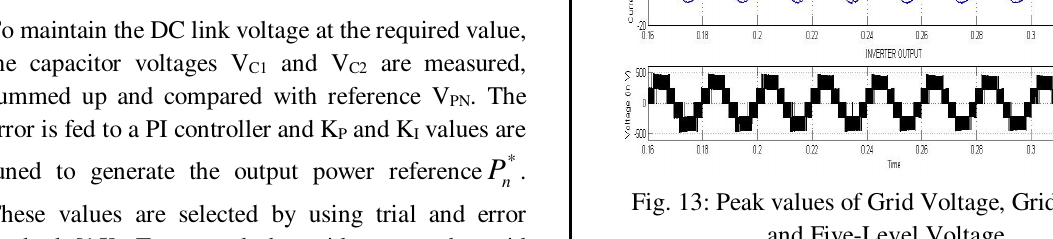
Fig. 13: Peak values of Grid Voltage, Grid Current and Five-Level